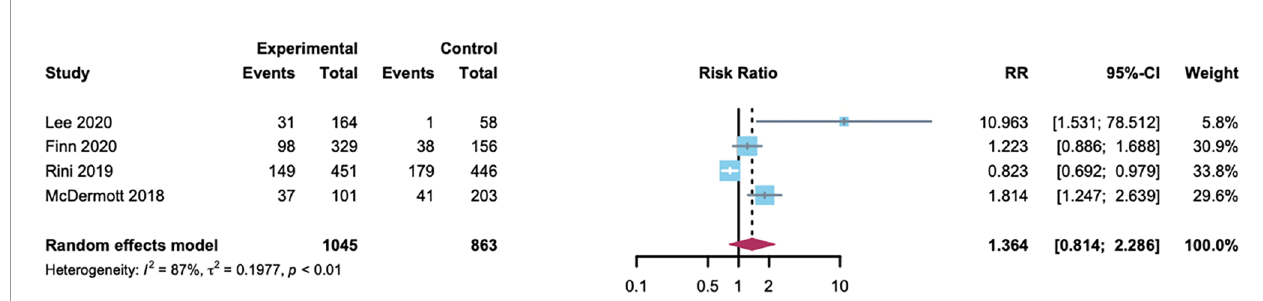
FIGURE 5 | The RR of atezolizumab plus bevacizumab-associated hypertension